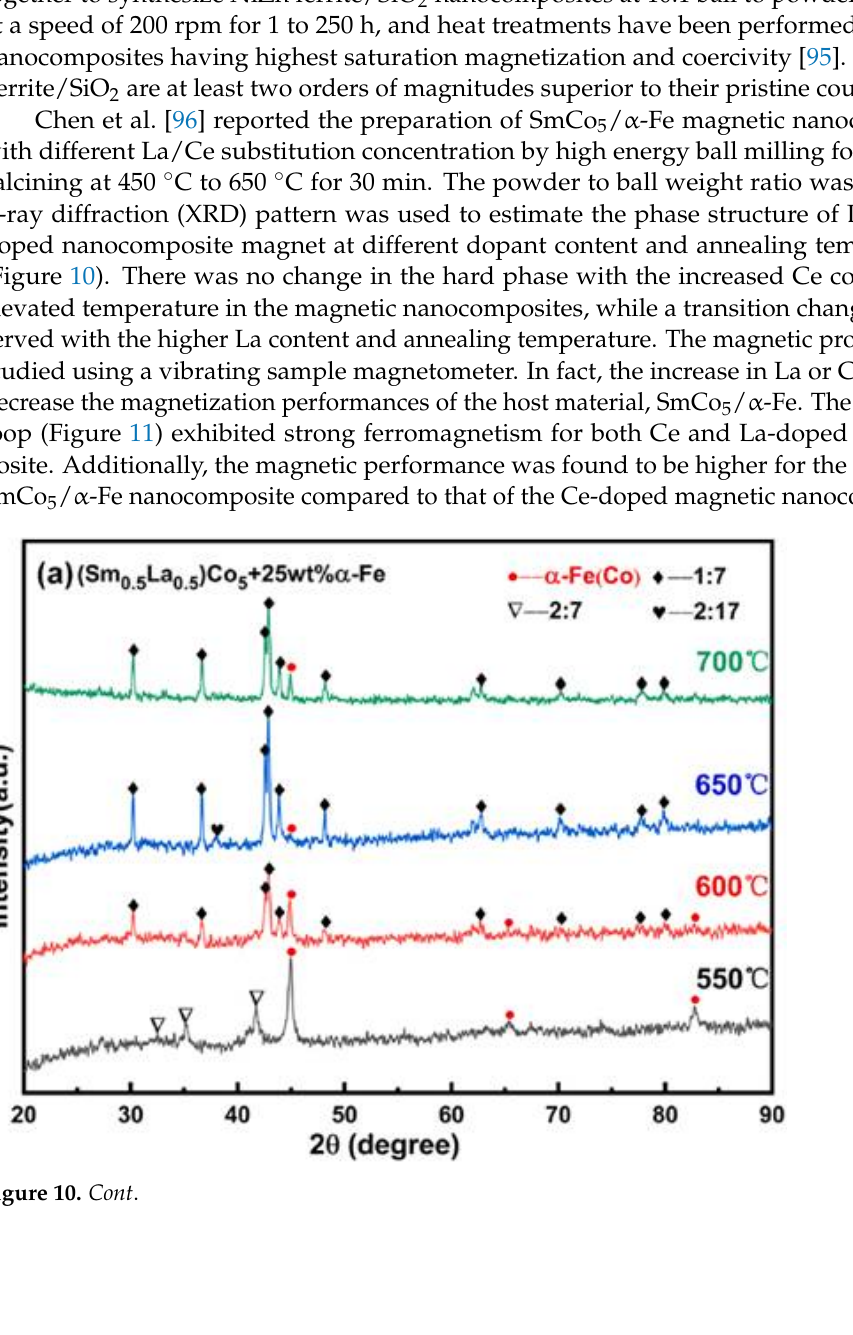
Figure 10. XRD patterns of ( a ) La-doped SmCo 5 / α -Fe ( b ) Ce-doped SmCo 5 / α -Fe at different anneal- ing temperatures [96]. (License obtained to use this Figure from Elsevier Publications, Journal of Magnetism and Magnetic Materials) .